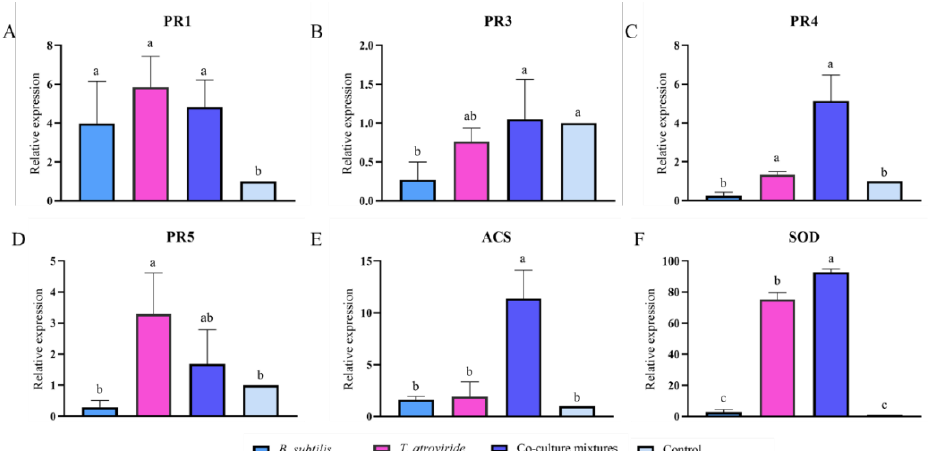
Figure 6. Expression of pathogenesis-related genes ( A ) PR1 , ( B ) PR3 , ( C ) PR4 , and ( D ) PR5 ; and ( E ) ethylene synthesis pathway ( ACS ) and ( F ) superoxide dismutase ( SOD )-related genes in wheat after the application of co-culture and axenic culture seed-coating agents. The synergistic action of co-culture was shown most significantly in the activation of the expression of the PR4 , PR5 , and SOD genes in wheat. a, b, c represent significant differences between the axenic and co-culture treatments ( p < 0.05).